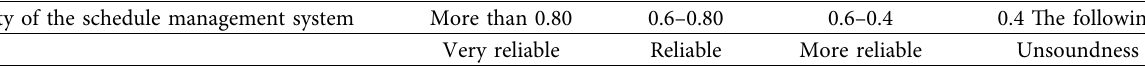
Table 2: Reliability evaluation rating of the construction progress management